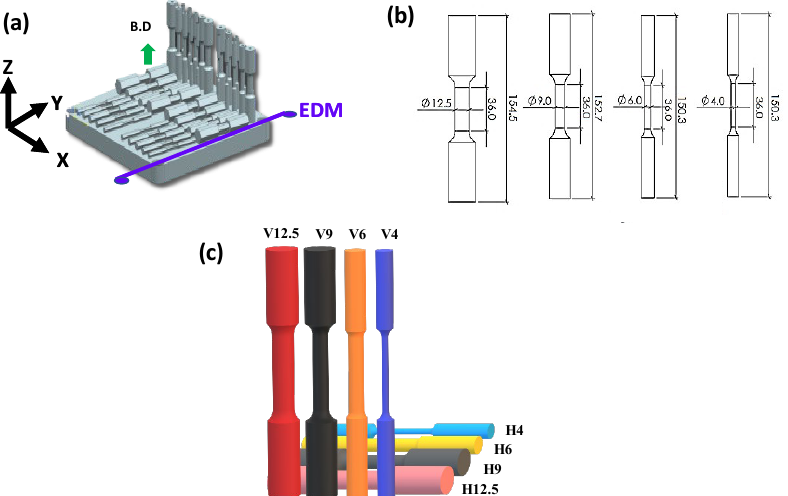
Figure 1. ( a ) Build set-up for the specimens in the EOS M-400 machine. ( b ) Size parameters defined for the samples after machining. All the dimensions are in mm. ( c ) Naming convention for the samples used in the study. The letter represents the orientation, and the corresponding number represents the gauge diameter of the machined sample.